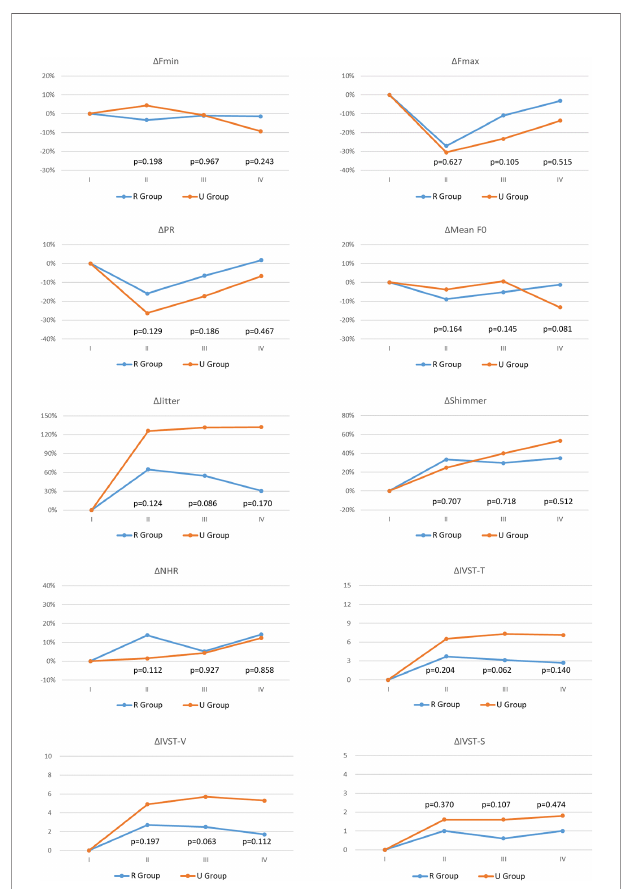
FIGURE 2 | Voice parameter changes ( D ) with different vocal cord movement (VFM) outcomes: R Group (Blue line) and U Group (Red line). Fmax, Maximum pitch frequency; Fmin, Minimum pitch frequency; PR, Pitch range; Mean F0, mean fundamental frequency; NHR, noise-to-harmonic ratio; IVST, Index of Voice and Swallowing Handicap of Thyroidectomy; IVST-T, Total IVST score; IVST-V, IVST score of voice domain score; IVST-S, IVST score of swallowing domain. period I, Preoperative period (within 2 months before surgery); period II, Immediate postoperative period (median duration of 3 days; range of 1-7 days); period III, Short-term postoperative period (median duration of 12 days; range of7-30 days); period IV, Long-term postoperative period (median duration of 40 days, range of 30-90 days). The equation for calculating postoperative change in objective voice analysis (Fmax, Fmin, PR, Mean F0, Jitter, Shimmer, NHR) data was D = (B - A)/A, the unit is %; the equation for calculating postoperative change in subjective voice analysis (IVST-T, IVST-V, IVST-S) data was D = B – A, the unit is score. Where A and B are preoperative and postoperative values, respectively. The preoperative D is 0 in all the voice parameter. p value <0.05, showed signi fi cant